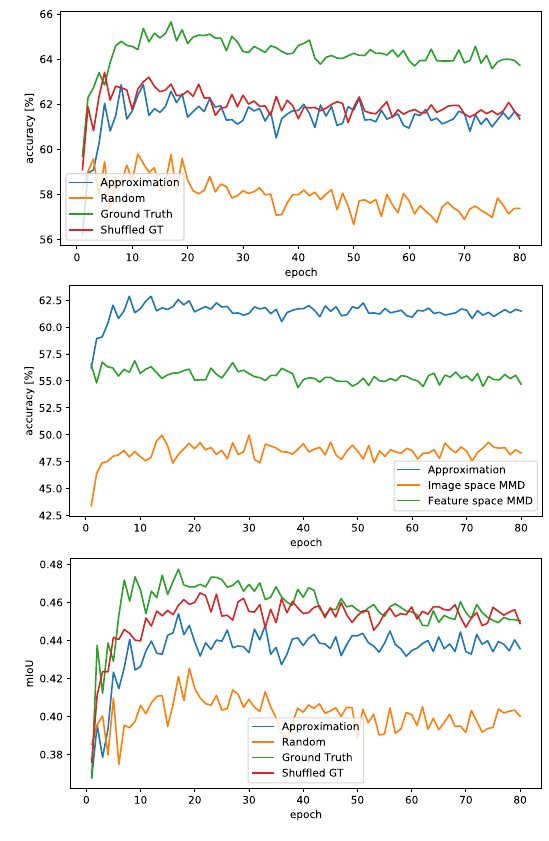
Figure 9. Comparing mapping strategies for DANN-like domain adaptation from Hannover (source) to Vaihingen (target) after which to stop training cannot be determined in a real world application due to the lack of target ground